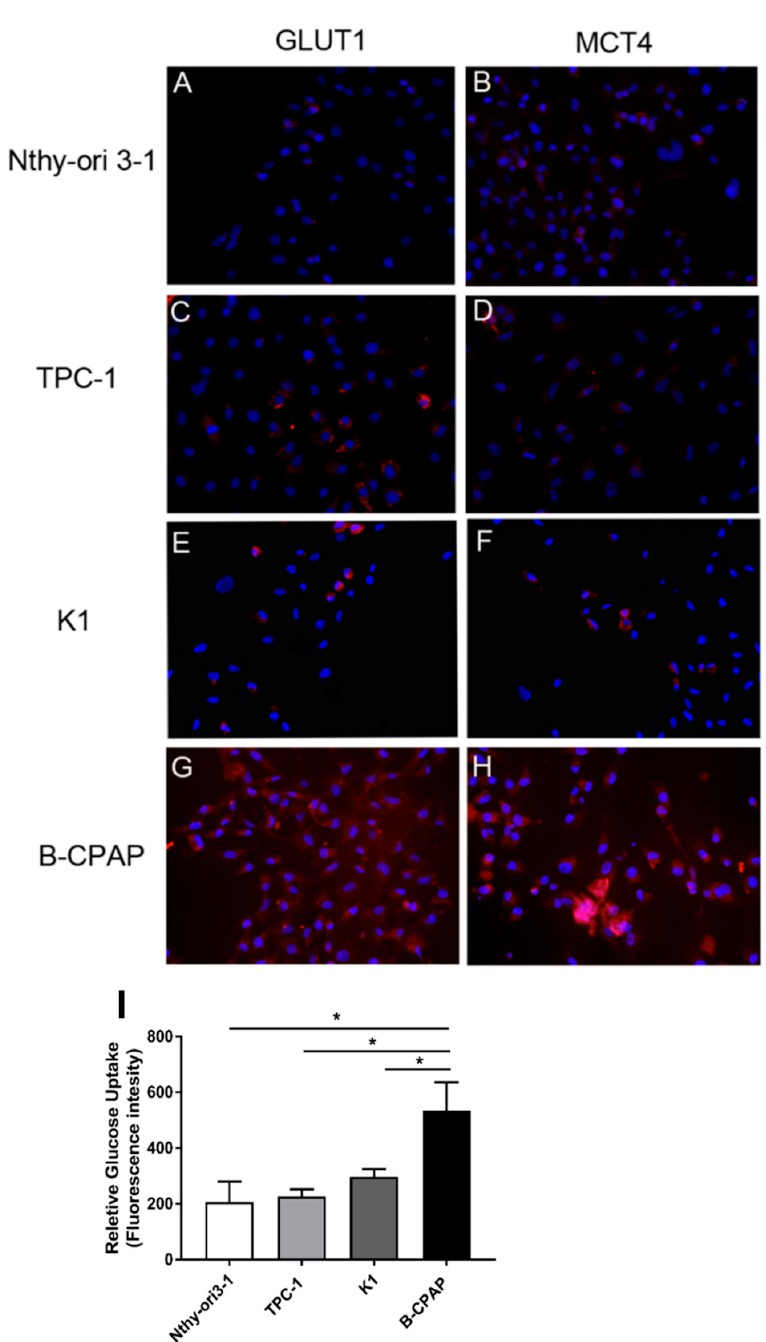
Figure 3. Expression of GLUT-1, MCT-4 and glucose uptake in PTC-derived cells . Immunofluorescence pattern for GLUT1 and MCT4 in Nthy-ori3-1 ( A , B ), TPC-1 ( C , D ), K1 ( E , F ) and B-CPAP ( G , H ). Nuclei were stained with DAPI (blue). Quantification of the relative glucose uptake was performed through the fluorescent glucose analog 2-NBDG in all cell lines ( I ). Data are expressed as media ± SD. All experiments were performed three times independently, each time in triplicate to confirm the results. Statistical analyses were performed by Student t -test. Results were considered significant when * p < 0.05, ** p < 0.01, *** p <